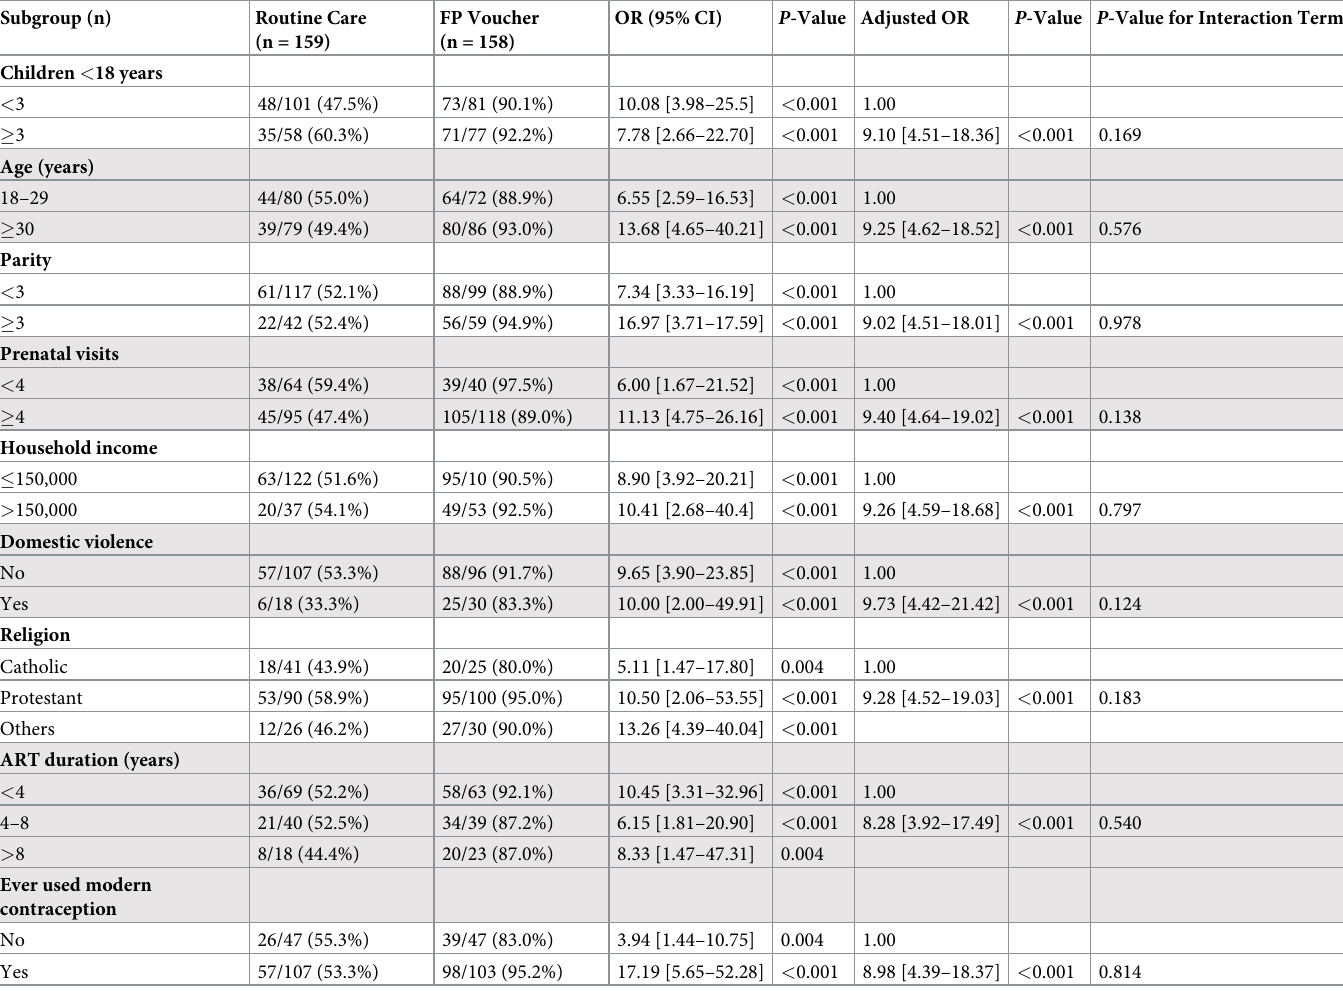
Table 3. Maternal baseline subcategories by study arm with initiation to FP at 8 weeks